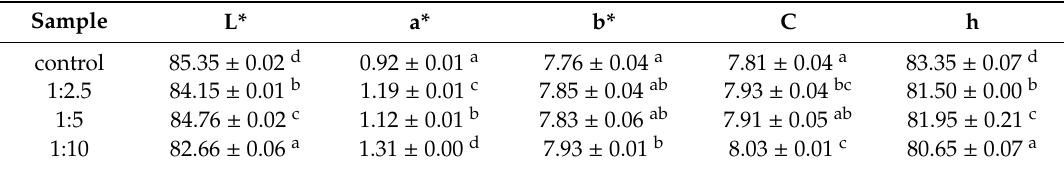
Table 6. E ff ects of ultrasound treatment on color of buckwheat